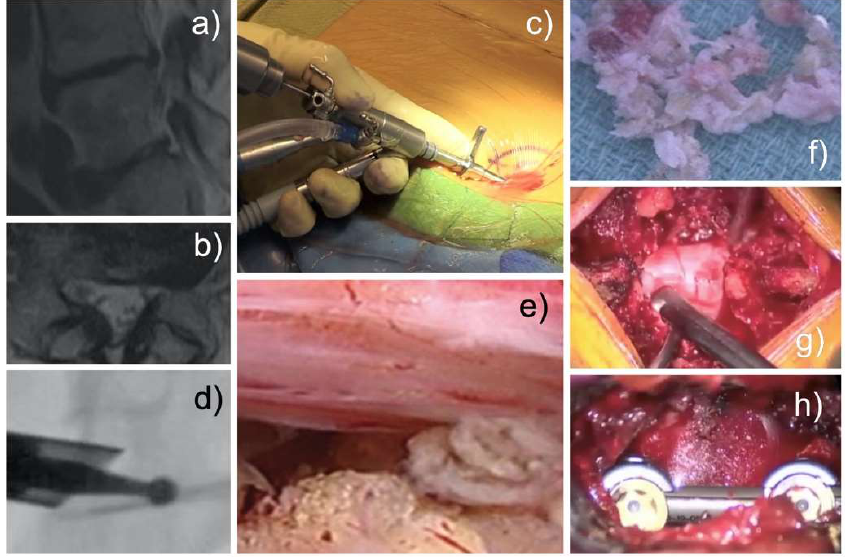
Figure 4. Preoperative T2-weighted sagittal ( a ) and axial MRI scans of a typical patient with multi- level lumbar degenerative disease and symptomatic L4/5 foraminal stenosis are shown ( a , b ). The patient underwent directly visualized ELD ( c ), with drills ( d ) and rongeurs introduced through a spinal endoscope’s inner working channel ( e ). In this case, the primary pain generator (PPG) was extruded disc fragments removed piecemeal after performing a foraminoplasty ( f ). Examples of an open laminectomy wound are shown in panel ( g ), and minimally invasive TLIF incision using a 22 mm tubular retractor are shown in panel ( h ).